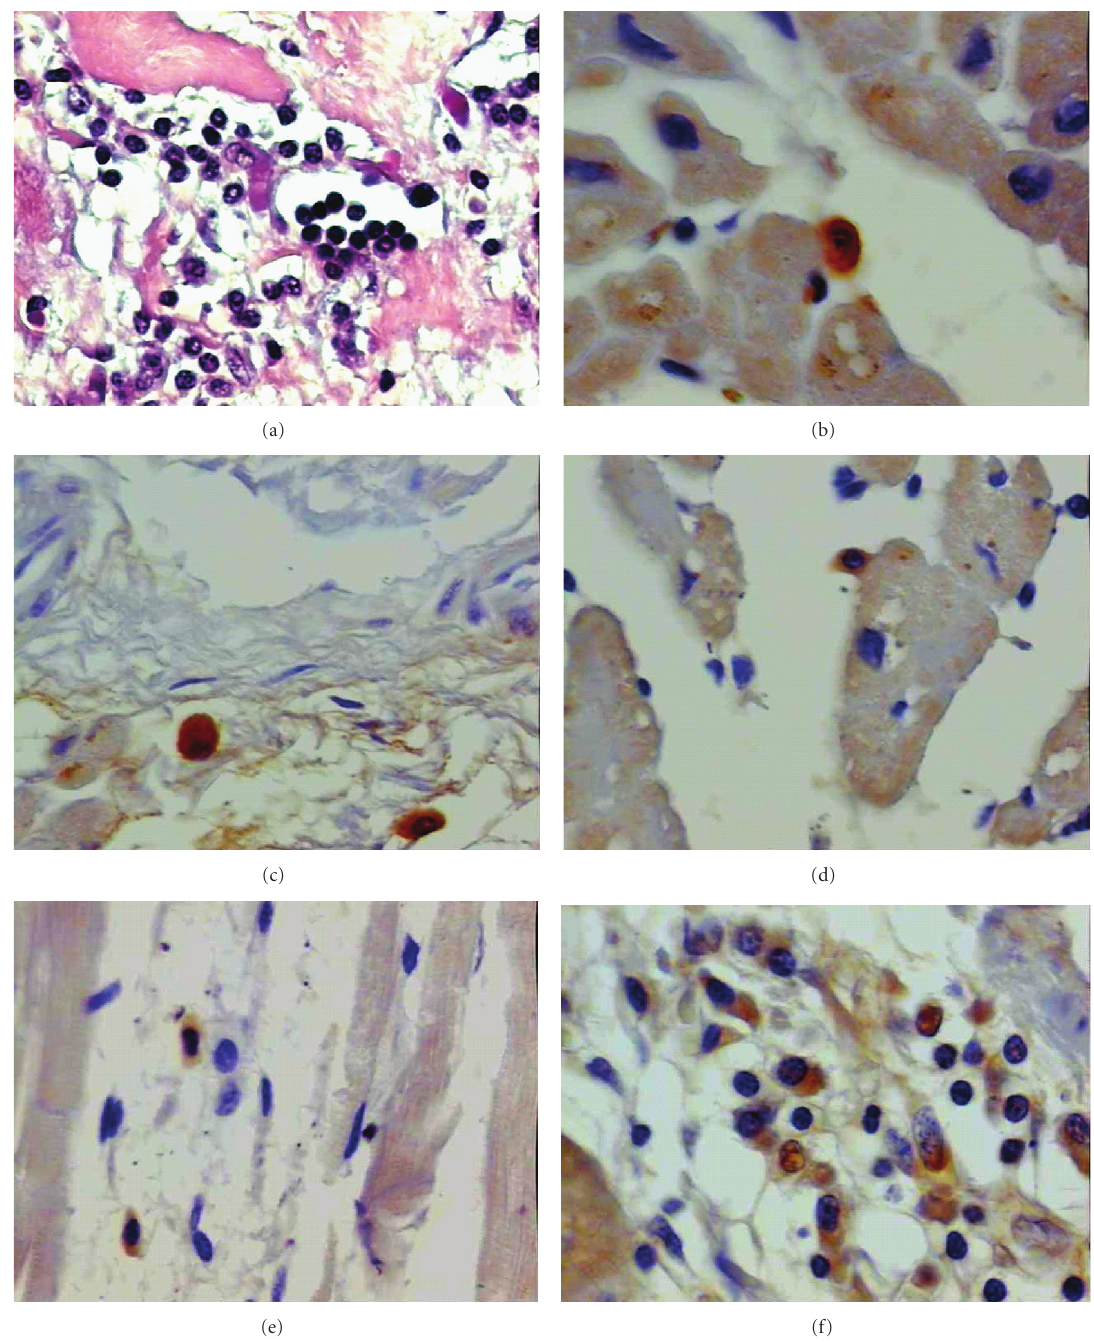
Figure 1: Histological sections of heart tissues obtained at autopsy from subjects with chronic chagasic cardiomyopathy. (a) Cellular exudation with a predominance of mononuclear cells around the fibrosis area (1,280X); (b) positive TNF- α staining and leukocytes in close contact with the myocardiocyte (1,280X); (c) positive IFN- γ staining in the inflammatory exudate (1,280X); (d) positive IL-4 staining in the inflammatory exudate and leukocytes in close contact with the myocardiocyte (600X); (e) discrete TGF- β immunostaining in the inflammatory exudate (1,280X); (f) positive NOS2 staining in the inflammatory exudate (1600X).